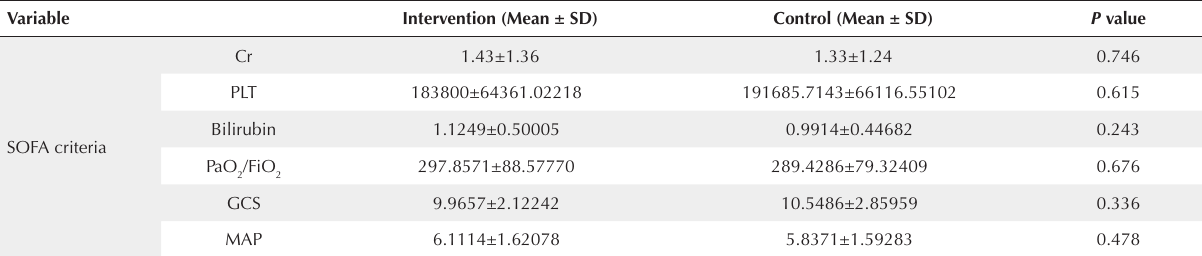
Table 2. SOFA criteria in two groups of participants Variable